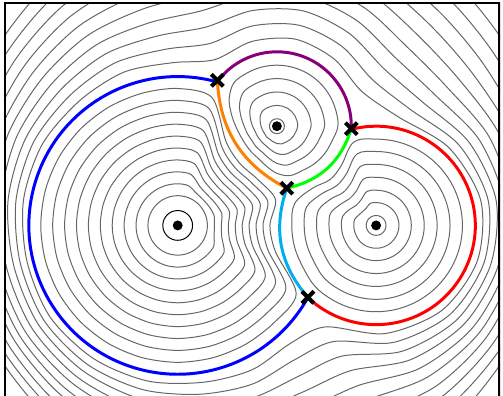
Figure A.12: Horizaontal trajectories of a Strebel differential on a Riemann sphere with four punctures. Black dots and crosses denote the (double) poles and zeros of the Strebel differential. The grey and colored lines describe the compact and non- compact horizontal trajectories respectively. The colored lines form a critical Strebel graph with six edges. This figure is taken from [ 1 ]